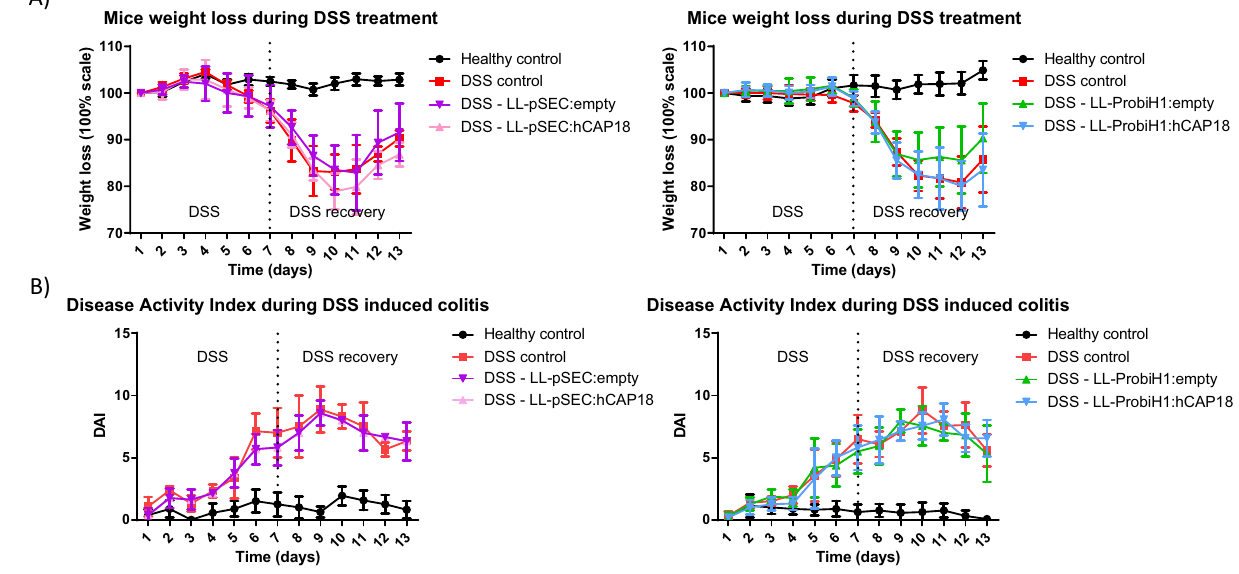
Figure 3. Effect of DSS on weight loss and disease activity index (DAI)on experimental groups receiving recombinant L. lactis or not. Effects of LL-Probi-H1-empty, LL-Probi-H1-hCAP18, LL-pSEC:empty and LL-pSEC:hCAP18 on recovery from DSS with respect to ( A ) body weight and ( B ) Disease Activity Index. Data represent mean ± SD. n = 8 mice per